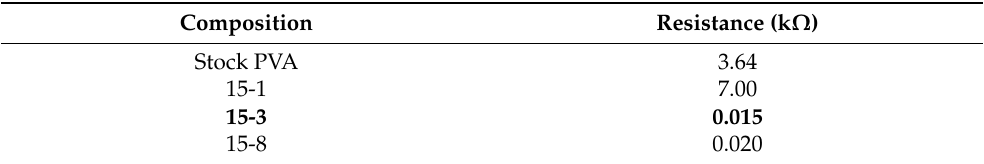
Table 2. Electrical resistance of printed silver as a function of magnesium salt present in PVA solution prior to